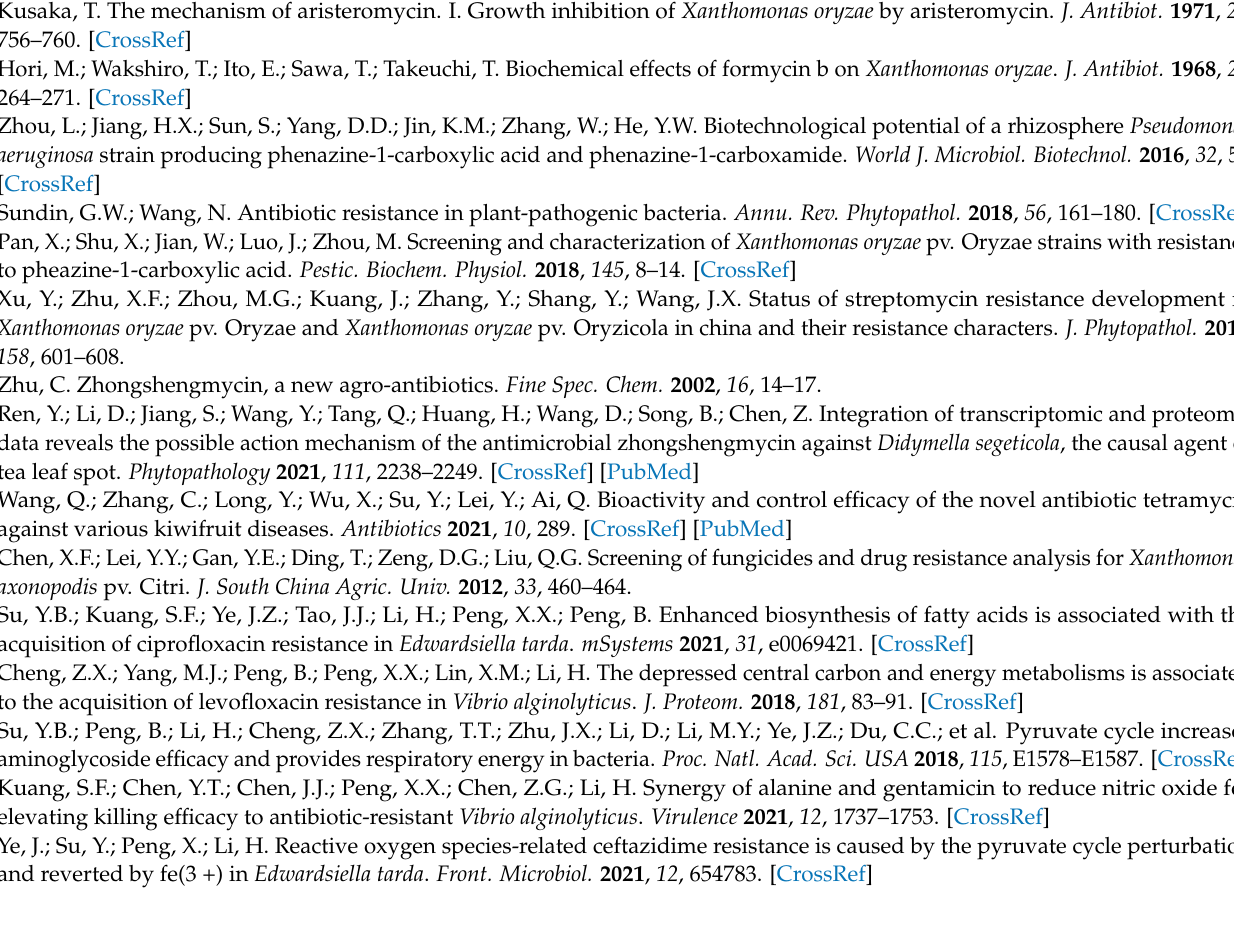
Figure S2: Pattern recognition and identification of crucial metabolites, Figure S3: The relative abundances of the 9 candidate crucial metabolites, Table S1. the primers used in this study for